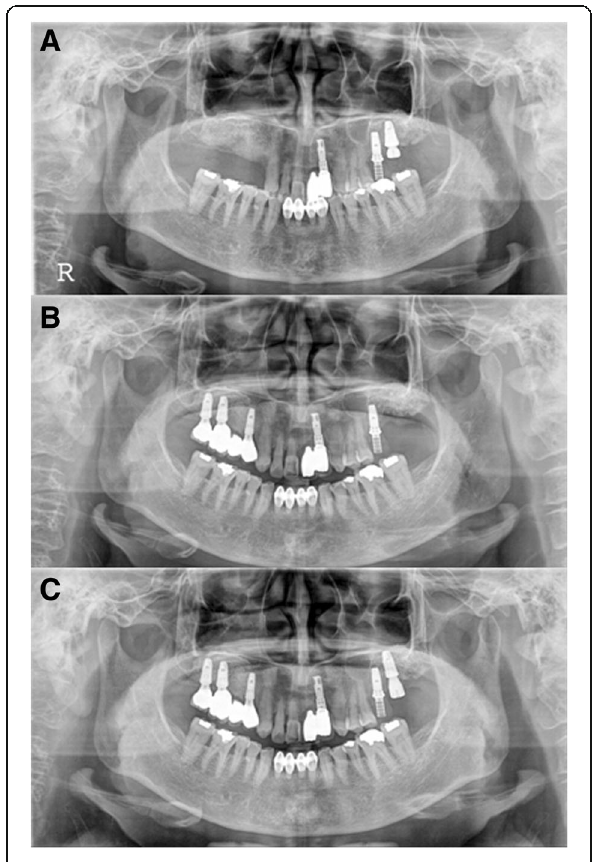
Fig. 7 F2, panoramic radiograph, a #27i second installation, b #27i second failure, preoperative panoramic radiograph, c #27i, third